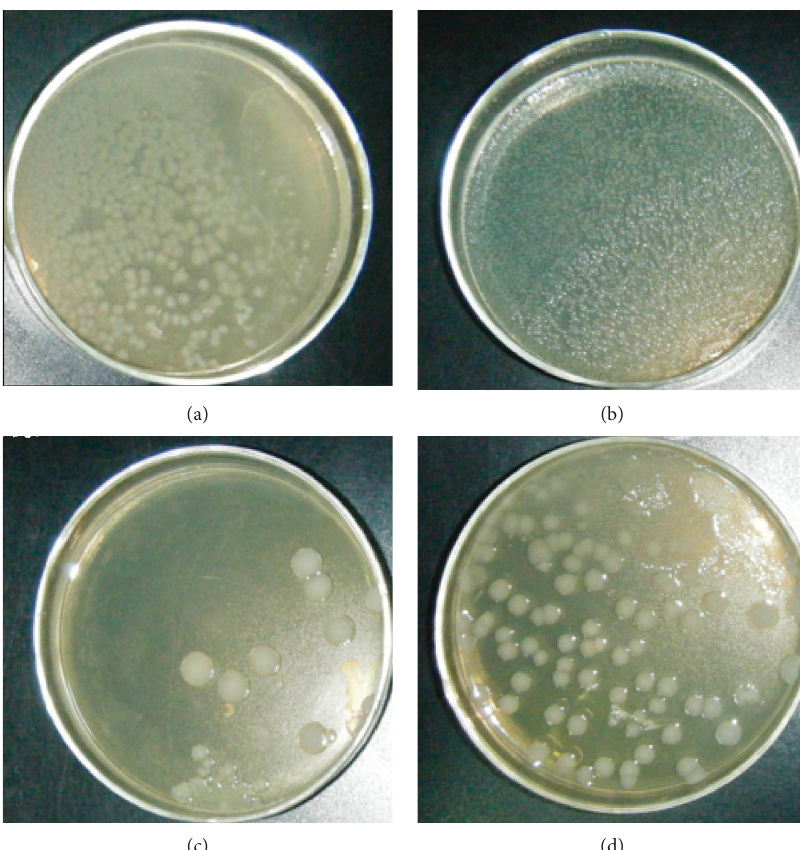
Figure 6: Agar plates before photocatalytic reaction (a) 0.1 at% of Fe-doped TiO (c) 0.1 at% of Fe-doped TiO 2 and (d) bare TiO 2 .